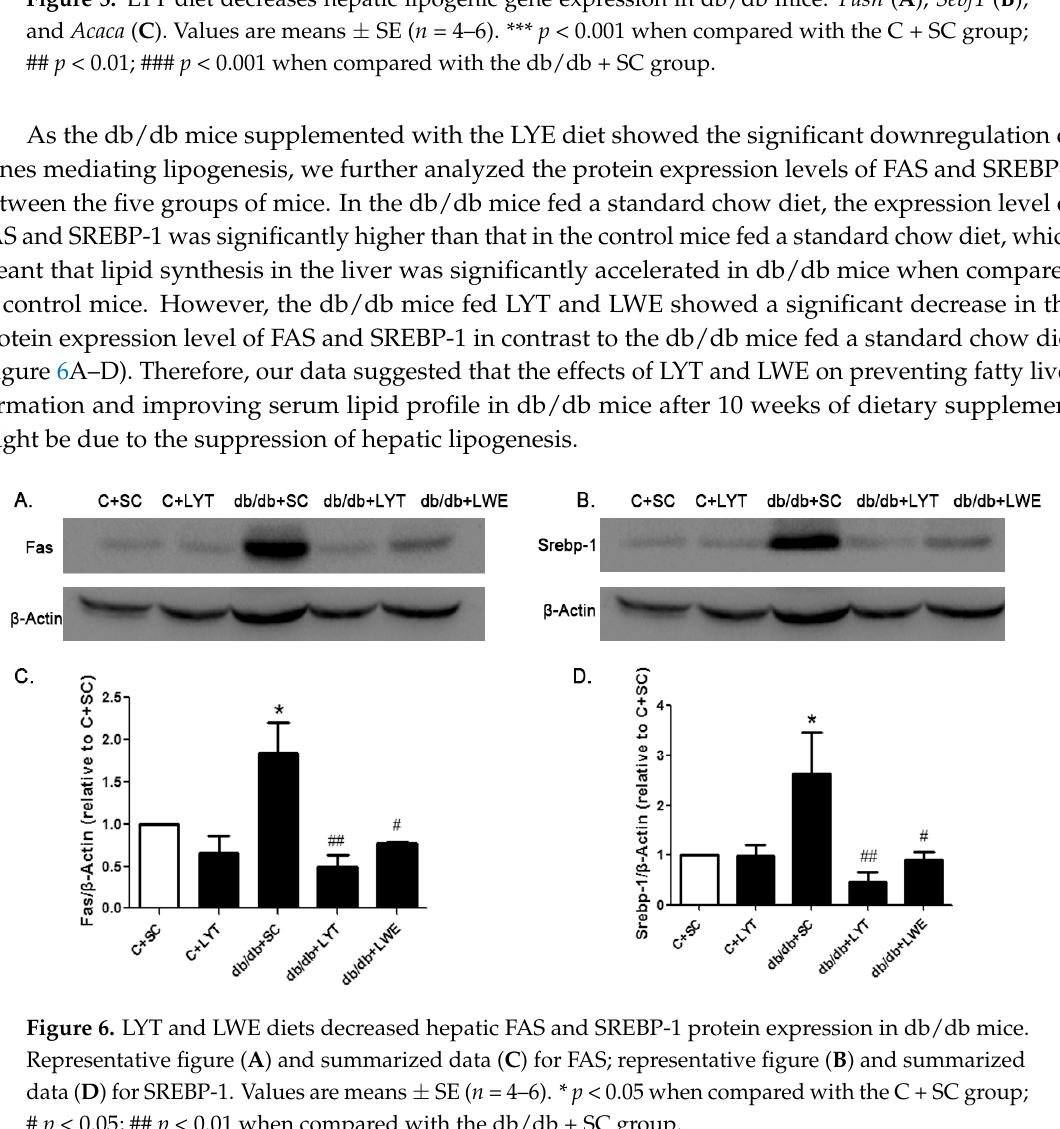
Figure 5. LYT diet decreases hepatic lipogenic gene expression in db/db mice. Fasn ( A ); Sebf1 ( B ); and